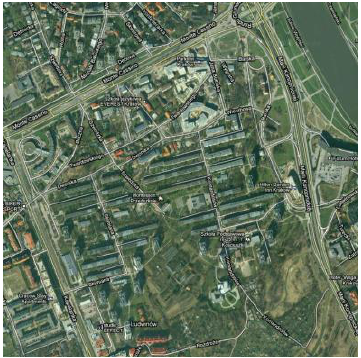
Fig. 2 Area of Cracow city selected for compilation (maps.google.pl)